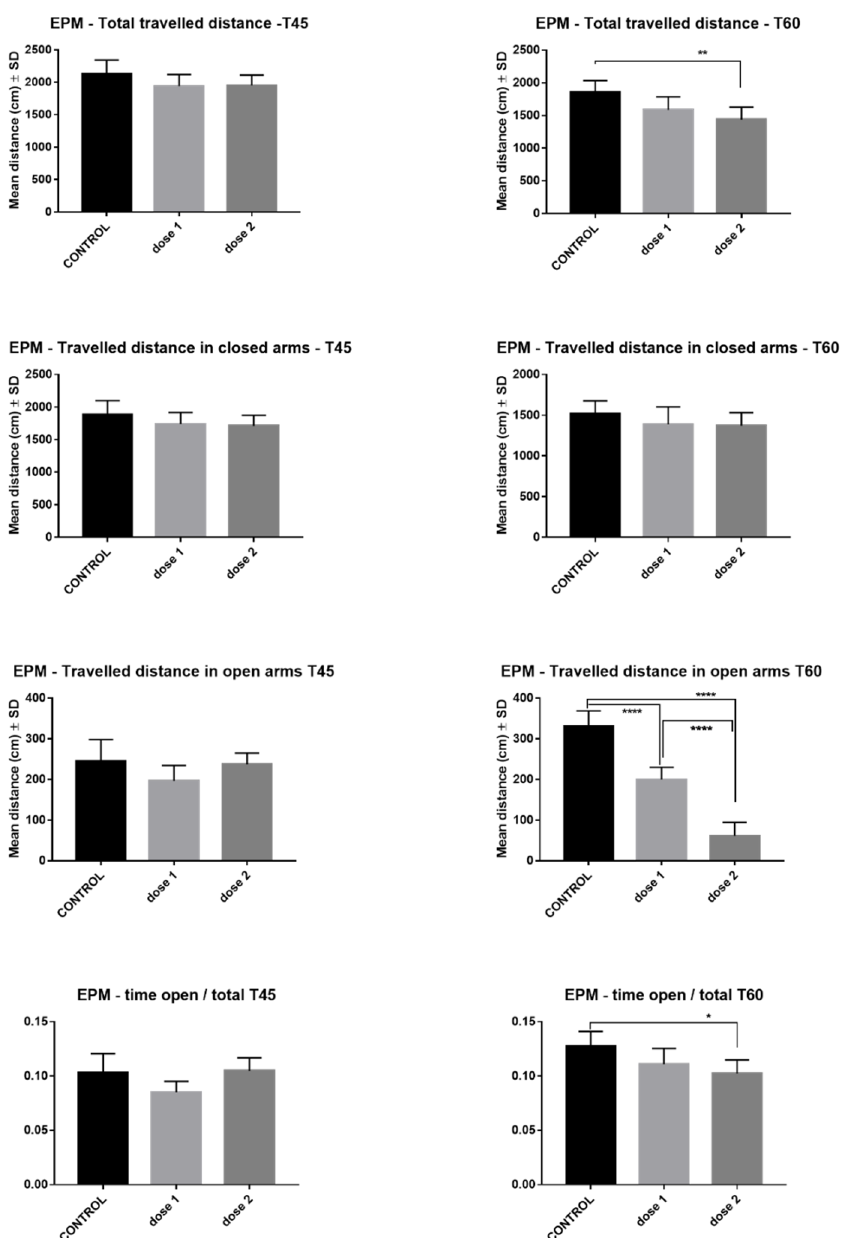
Figure 5. Elevated Plus Maze—comparison between control, low-dose (D1), and high-dose (D2) groups in rats sacrificed immediately after end of treatment (T45) and those sacrificed 15 days post-treatment (T60). * p < 0.05; ** p < 0.01; **** p < 0.0001.